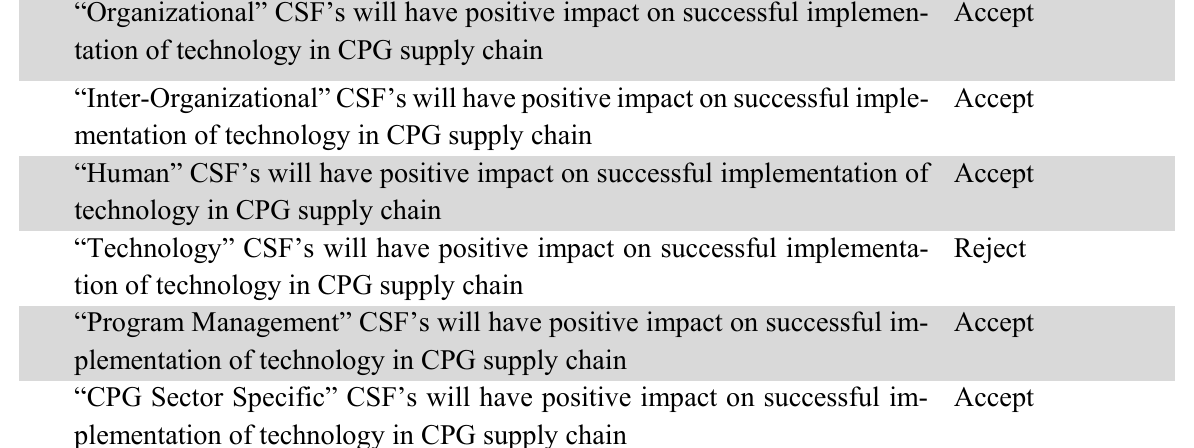
Impact of Critical Success Factors (CSFs) on successful technology implementation “Organizational” CSF’s will have positive impact on successful implemen- tation of technology in CPG supply chain “Inter-Organizational” CSF’s will have positive impact on successful imple- mentation of technology in CPG supply chain “Human” CSF’s will have positive impact on successful implementation of technology in CPG supply